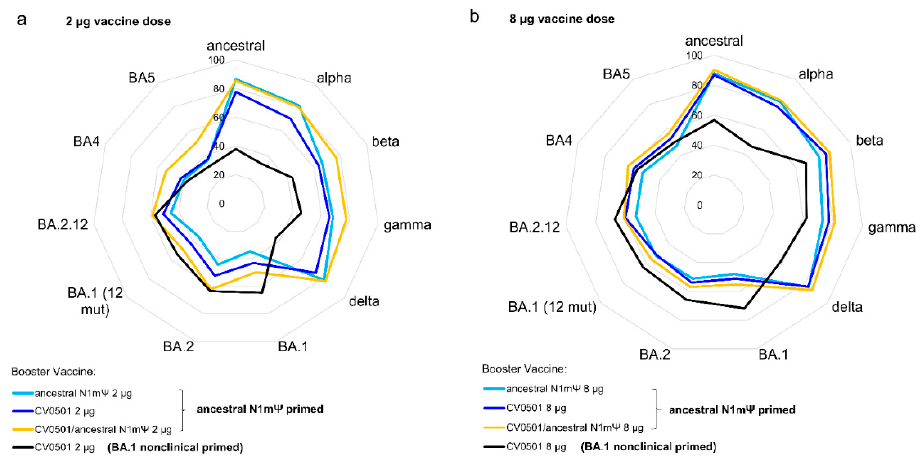
Figure 5. Priming of rats with ancestral N1m Ψ results in induction of broader ACE2-binding inhibiting antibodies compared to priming with BA.1 nonclinical with little variance induced by selection of booster vaccine. Wistar rats ( n = 8/group) were primed on Days 0 and 21 with 2 or 8 µ g of ancestral N1m Ψ or BA.1 nonclinical (black line) and boosted on Day 105 with either CV0501 alone (dark blue line and black line), ancestral N1m Ψ alone (light blue line) or the bivalent combination CV0501/ancestral N1m Ψ (orange line). Sera collected on Day 133 from rats receiving 2 µ g vaccines was diluted 1:1600 ( a ) and from rats receiving 8 µg vaccines was diluted 1:3200 ( b ) for the ACE2 binding inhibition assay. Data are displayed as the percentage RBD-binding inhibition, with 0% being in the inner circle and 100% in the outmost circle.